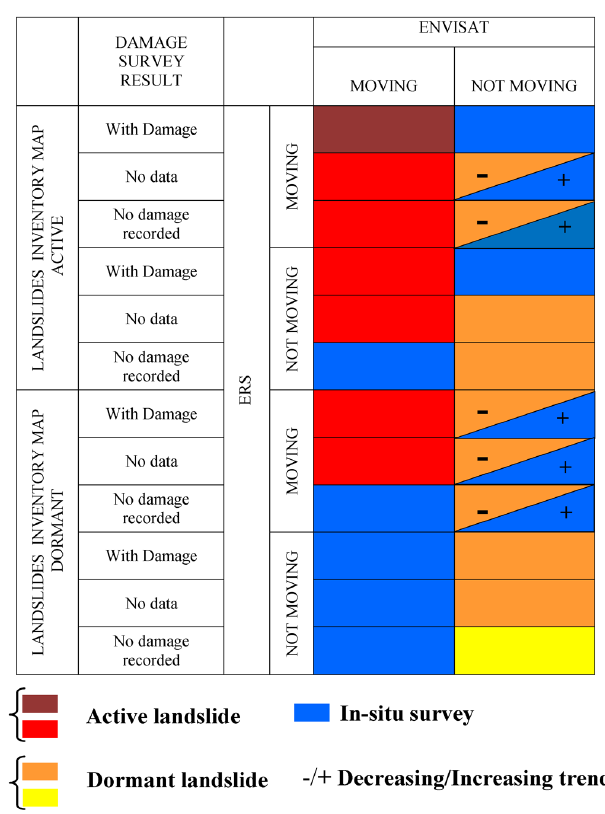
Fig. 12. The DInSAR-Damage